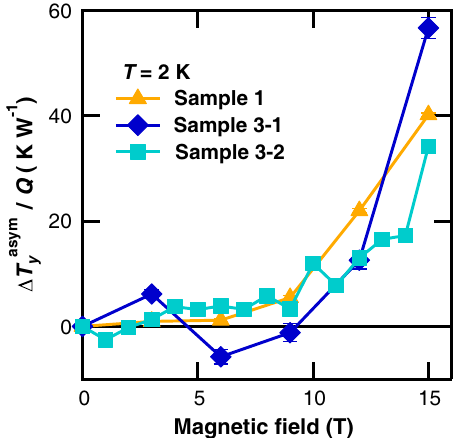
FIG. 6. Magnetic field dependence of the asymmetrized trans- verse temperature difference divided by the heat current ð Δ T asym y =Q Þ at 2 K. Error bars represent the standard error of the